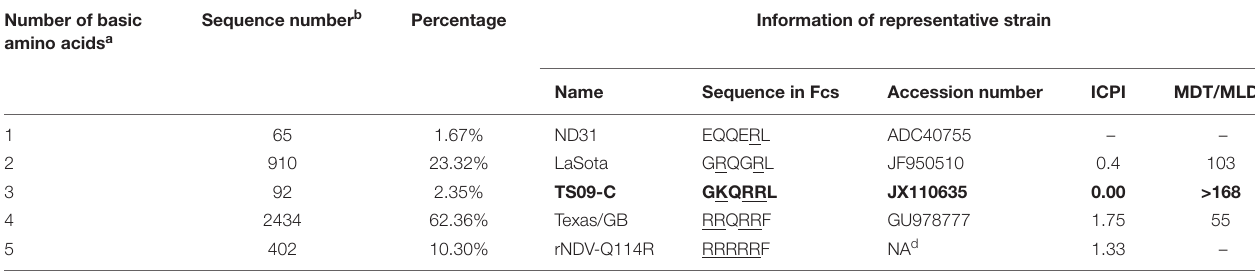
FIGURE 6 | Viral titers in different tissues of chickens inoculated with different NDV strains. SPF chicken embryos were inoculated with NDVs rLaSota, rTS09-C, rTS-2B, or PBS. Lung, trachea, duodenum, liver, kidney, spleen, and muscle samples were collected from birds vaccinated in ovo , at 2 (A) and 4 dpi (B) . The viral titer of each sample was determined in BHK21 cells. Statistical significance in the viral titers was determined with a two-tailed t test (ns, p > 0.05; * p < 0.05; ** p < 0.01). TABLE 4 | Summary of sequence information at the NDV F protein cleavage